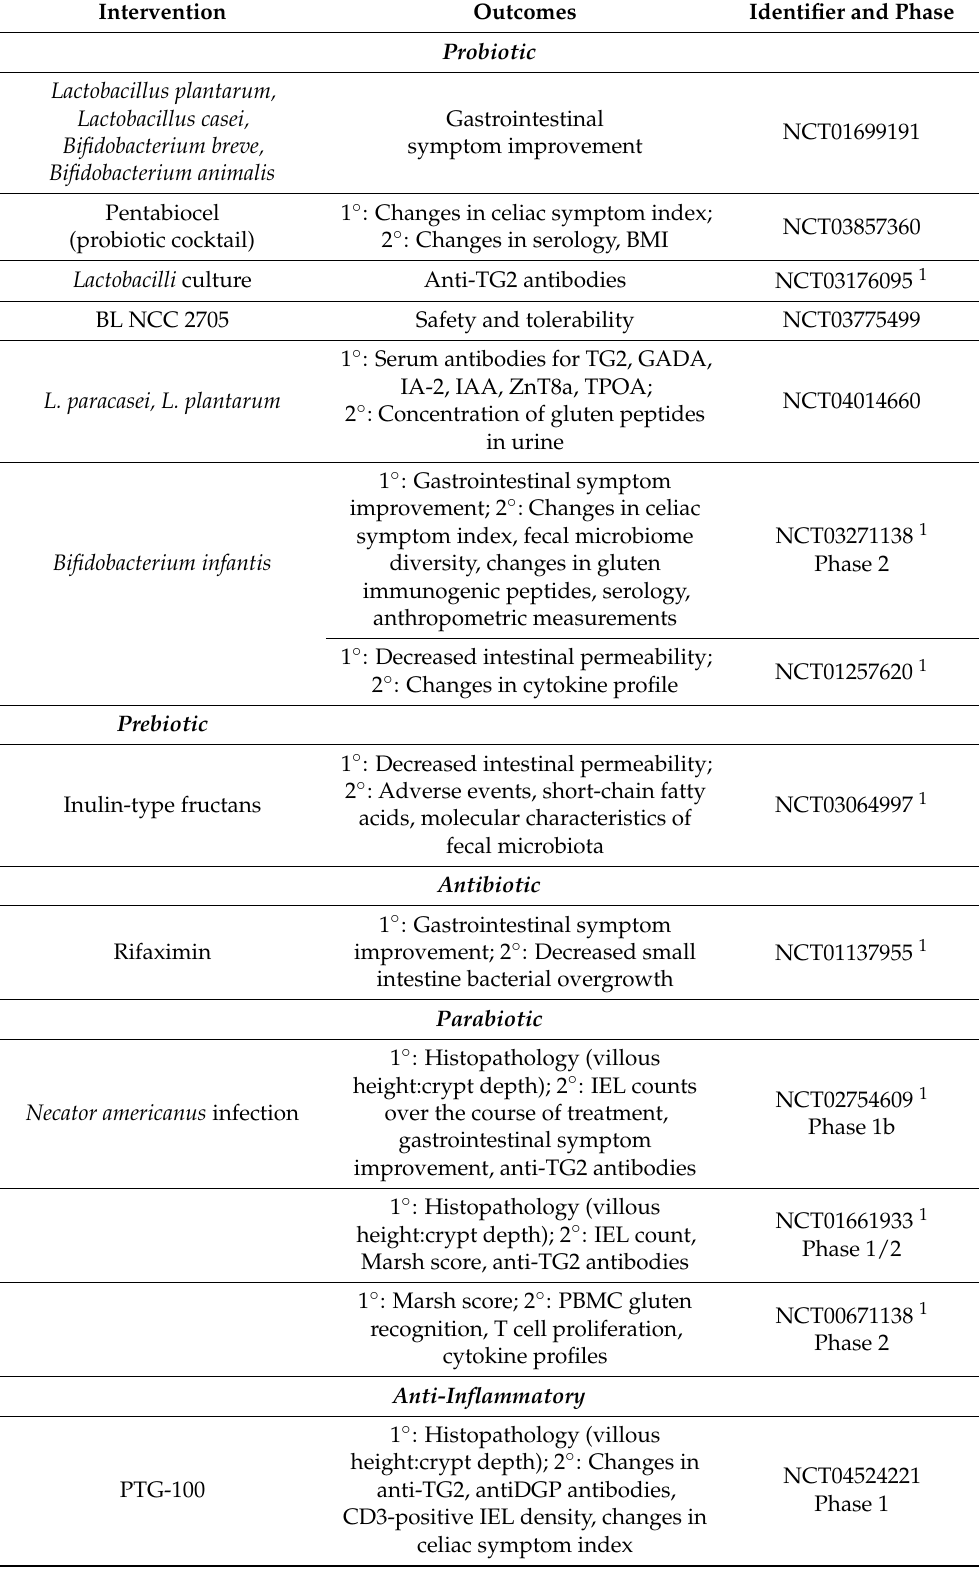
Table 1. Current and ongoing clinical trials for celiac disease treatments beyond the scope of the gluten-free diet as of December